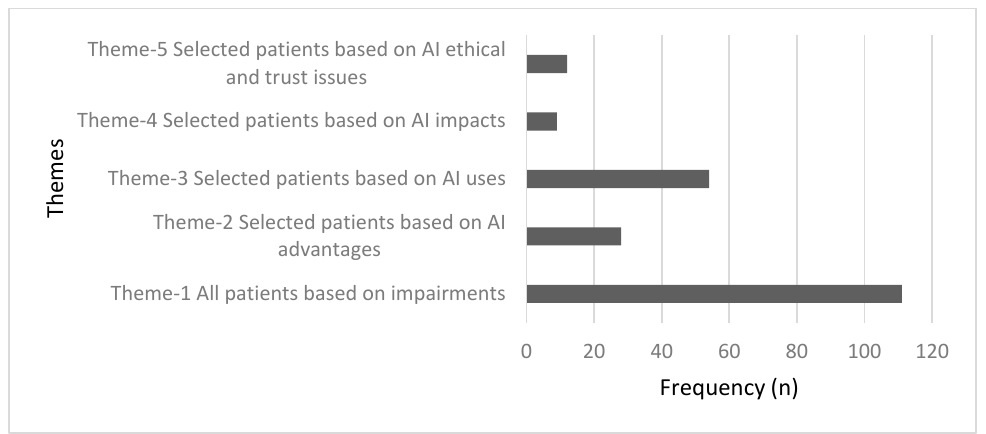
Figure 2 . Frequency of the main themes generated from PTs’ responses to the first open-ended question. Theme 1 was the predominant theme that showed most PTs believed in the customization of AI based on patients’ impairments.